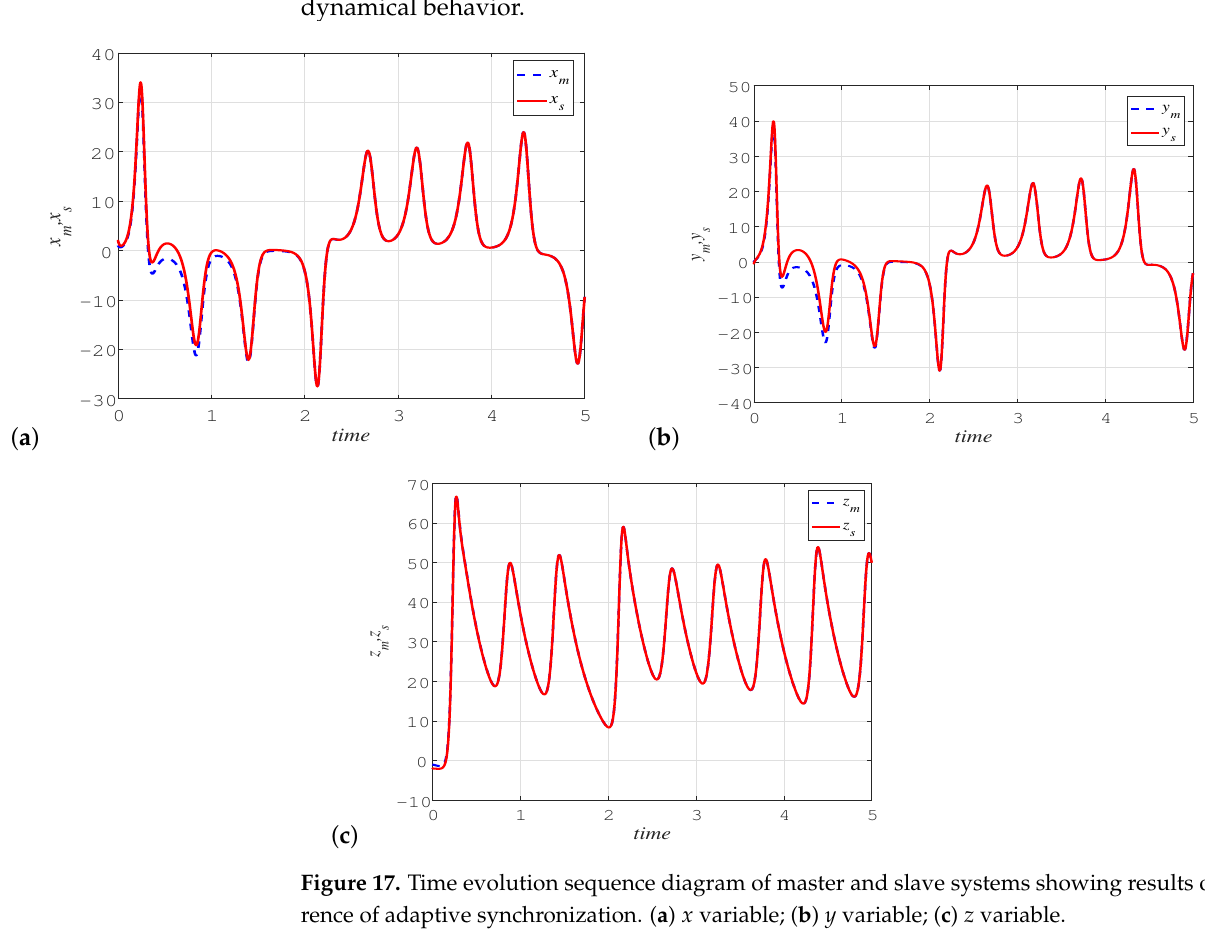
Figure 17. Time evolution sequence diagram of master and slave systems showing results of occur- rence of adaptive synchronization. ( a ) x variable; ( b ) y variable; ( c ) z variable.